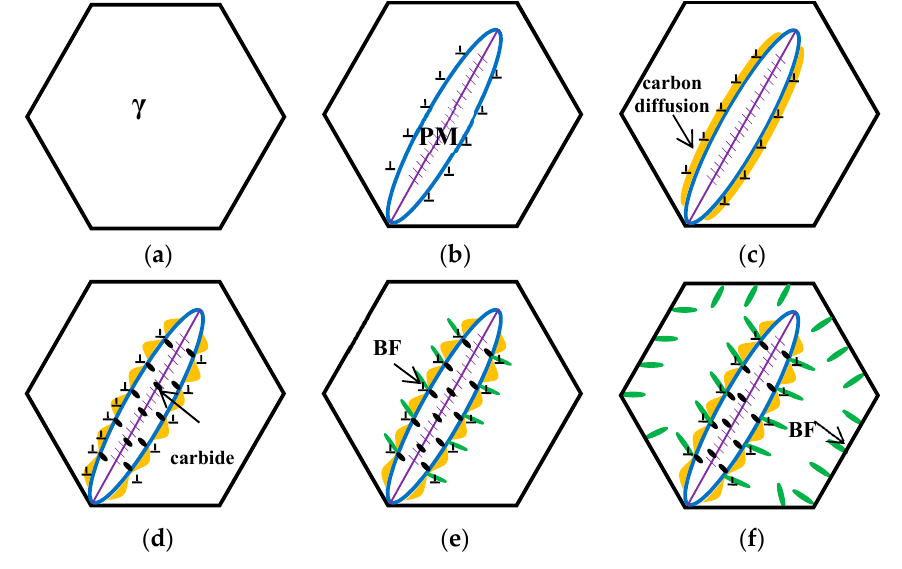
Figure 8. Schematics diagrams of QBT process.